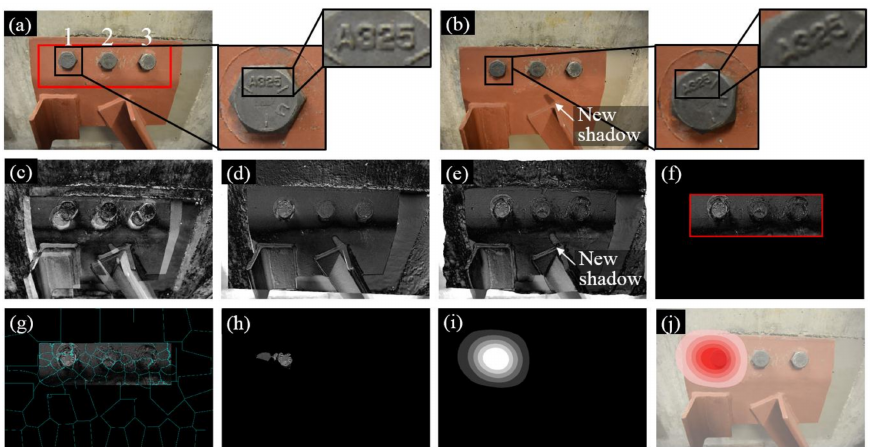
Figure 15. Experimental results under varying lighting conditions: ( a ) Image 1 taken during the first inspection period; ( b ) Image 2 taken during the second inspection period; ( c ) initial errors between Image 1 and 2; ( d ) errors after feature-based image registration; ( e ) errors after intensity-based image registration; ( f ) windowing applies to the registration errors; ( g ) registration errors segmented into superpixels; ( h ) feature enhancement; ( i ) Gaussian filtering; and ( j ) result implementation.